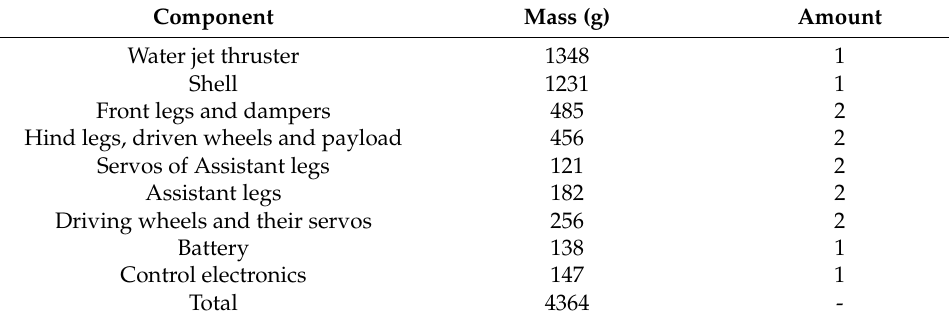
Figure 1. The prototype of the proposed jumping robot. Table 1. Main components of jumping